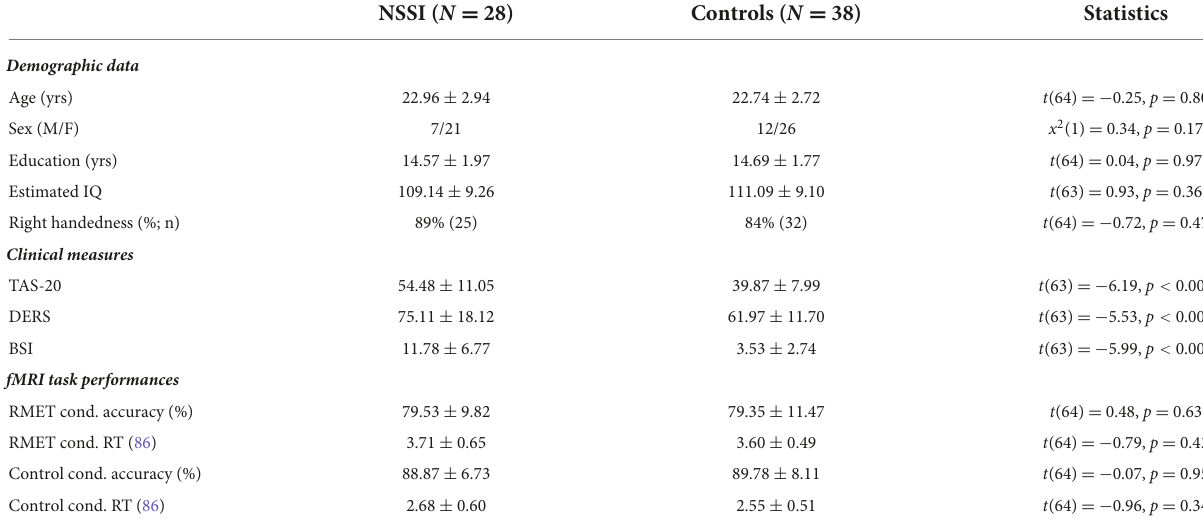
TABLE 1 Demographic, clinical, and task performance data of the study